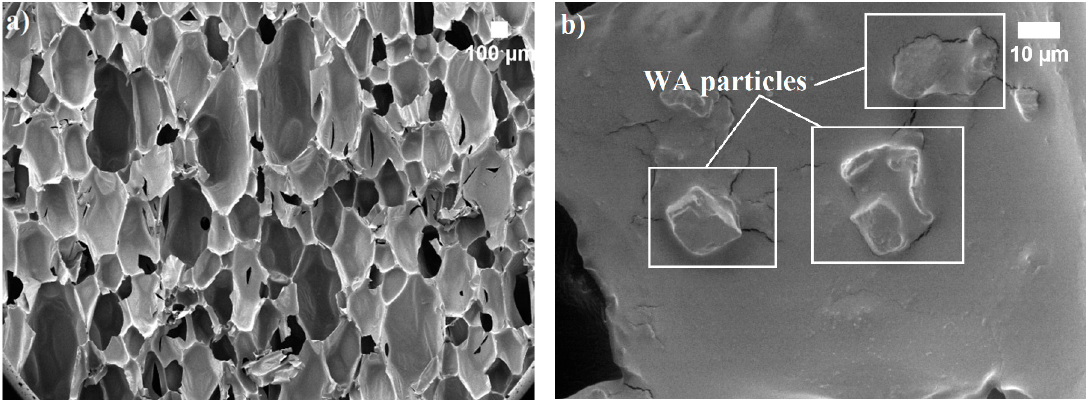
Figure 1. WA particles in WAPU-50 foam structure: ( a ) ×35 magnification; ( b ) ×1000 magnification.